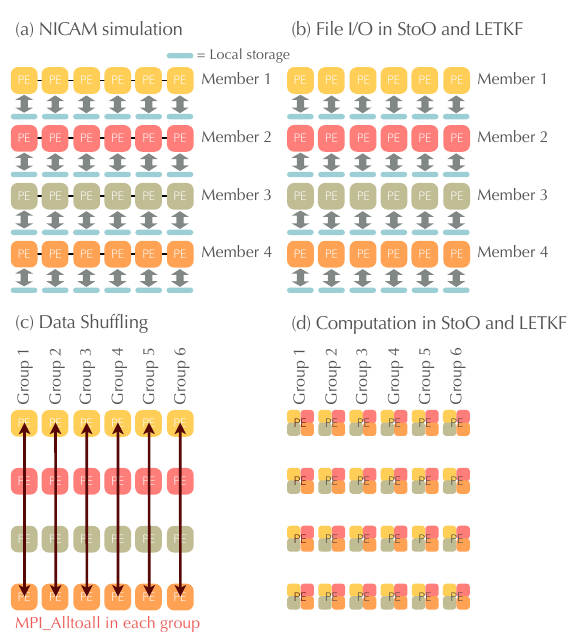
Figure 2. Schematic diagram of the proposed framework in NICAM–LETKF. PE means individual MPI processes.